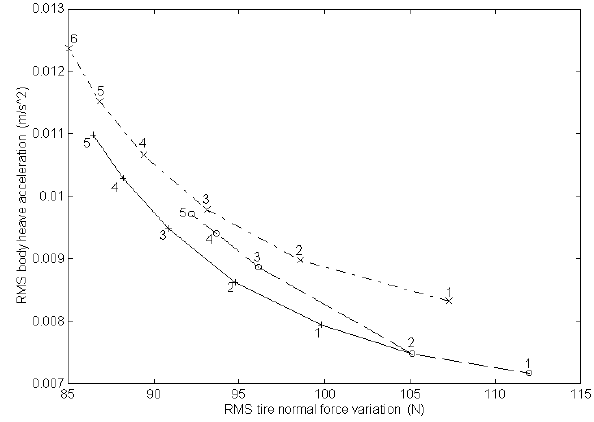
Figure 8. Tire normal force variation vs. heave acceleration.